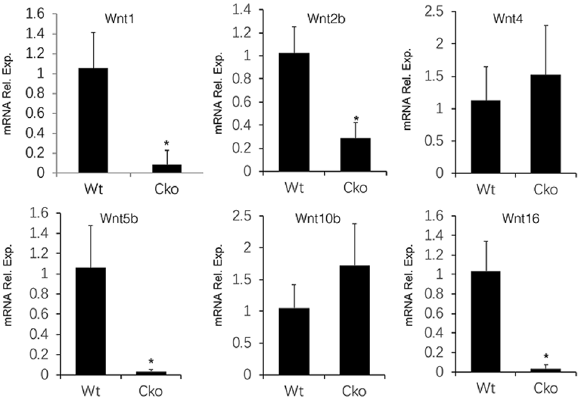
Figure 1. Bmpr1a deletion diminishes Wnt expression in cortical bone. Relative mRNA levels of Wnt genes determined by RT-qPCR in the cortical bone of wild type (WT) versus Dmp1-Cre; Bmpr1a f/f (CKO) male littermates at P33. *: P < 0.05, Student’s t-test, n =